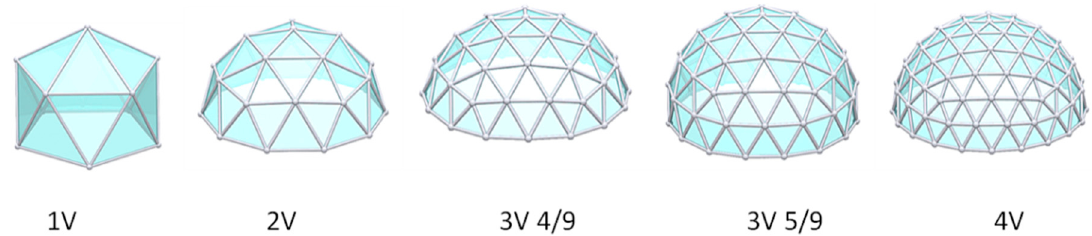
Figure 3. Different types of icosahedron-based geodesic domes [36]. Reproduced with permission from Rene K. Mueller, SimplyDifferently.org; published by 2014.